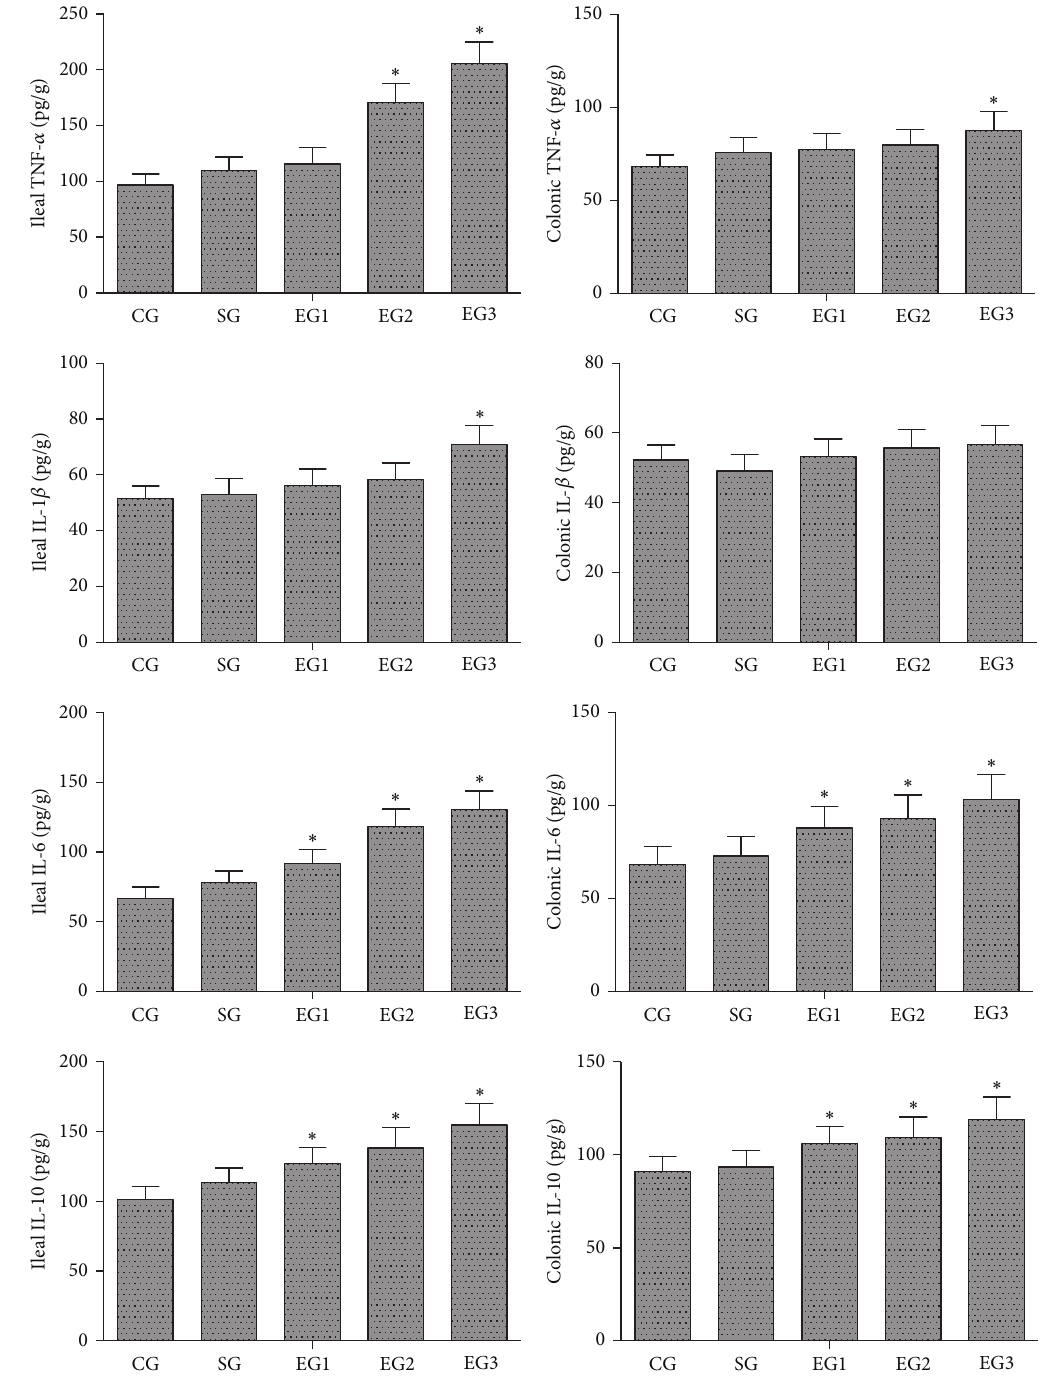
Figure 3: Concentrations of TNF- 𝛼 , IL-1 𝛽 , IL-6, and IL-10 in the tissues of ileum and colon. CG: control group; SG: sham group; EG1, EG2, and EG3: exposure groups with peritoneal air exposure for 1, 2, and 3h, respectively. Data are expressed as mean ± SD, 𝑛 = 8 . ∗ 𝑃 < 0.05 , versus the CG